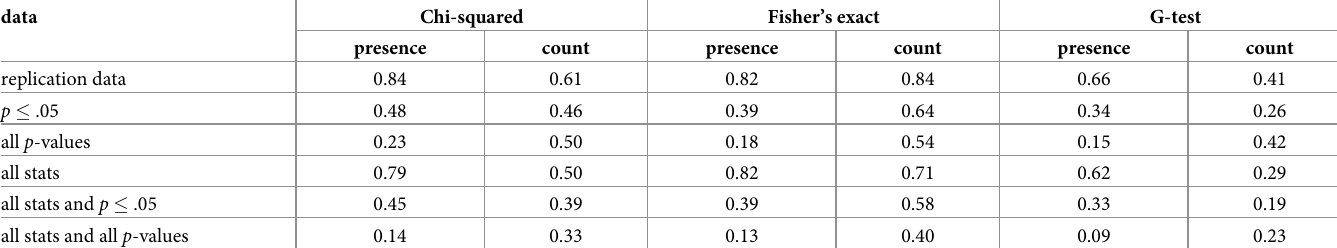
Table 8. Multiverse analysis on association between decision errors and data sharing in the replication data